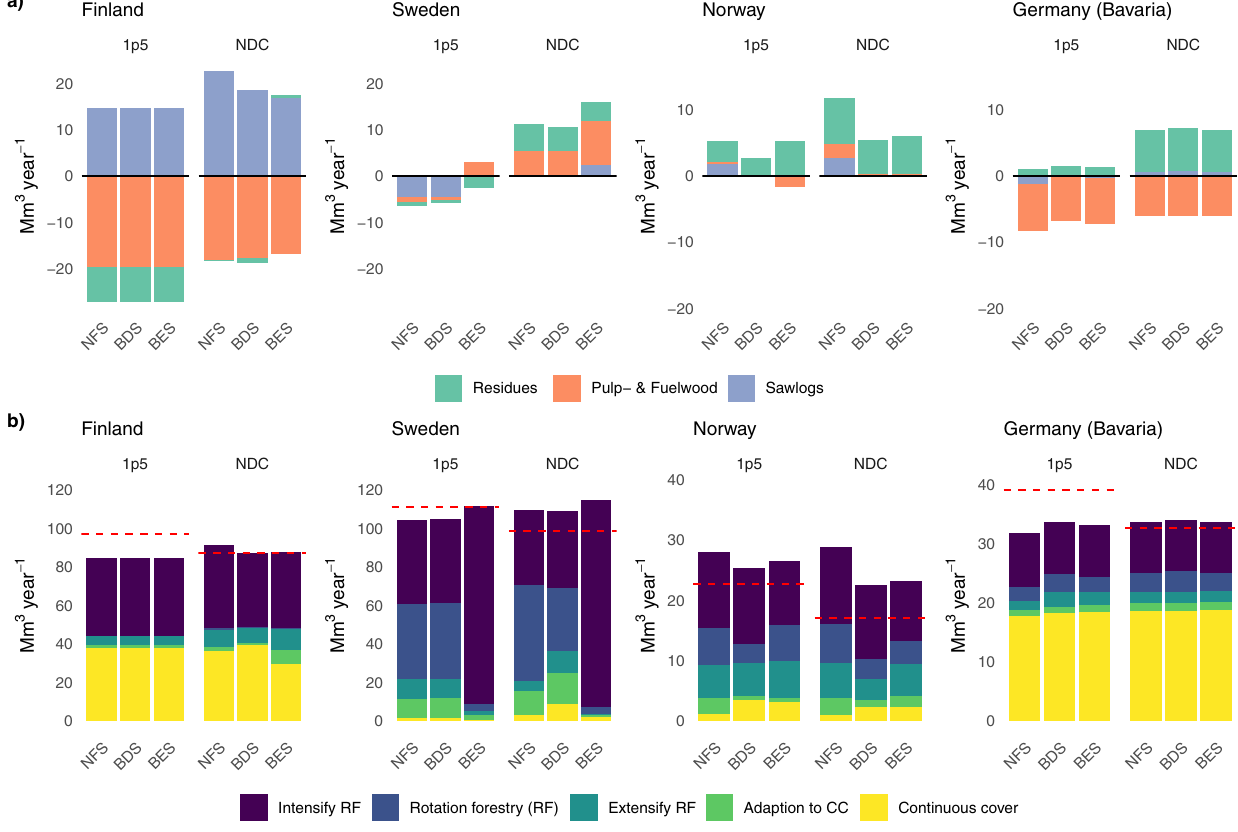
Fig. 4 Top-down optimization outcomes prioritizing harvest demands for EU climate change mitigation targets above national policy demands. a Difference between harvest demands for EU mitigation targets (1p5 and NDC, see Fig. 2) and forecasted harvests under optimization scenarios by assortment. Bars below the black line indicate that the demand for that assortment is not met. b Forecasted harvests by management classes. The bars in both plots, a and b represent mean values over the planning horizon. The red dashed line in b represents the average timber demand of each mitigation target, NFS stands for national forest strategy, BDS for biodiversity strategy, and BES for bioeconomy strategy. Note variable scaling of y